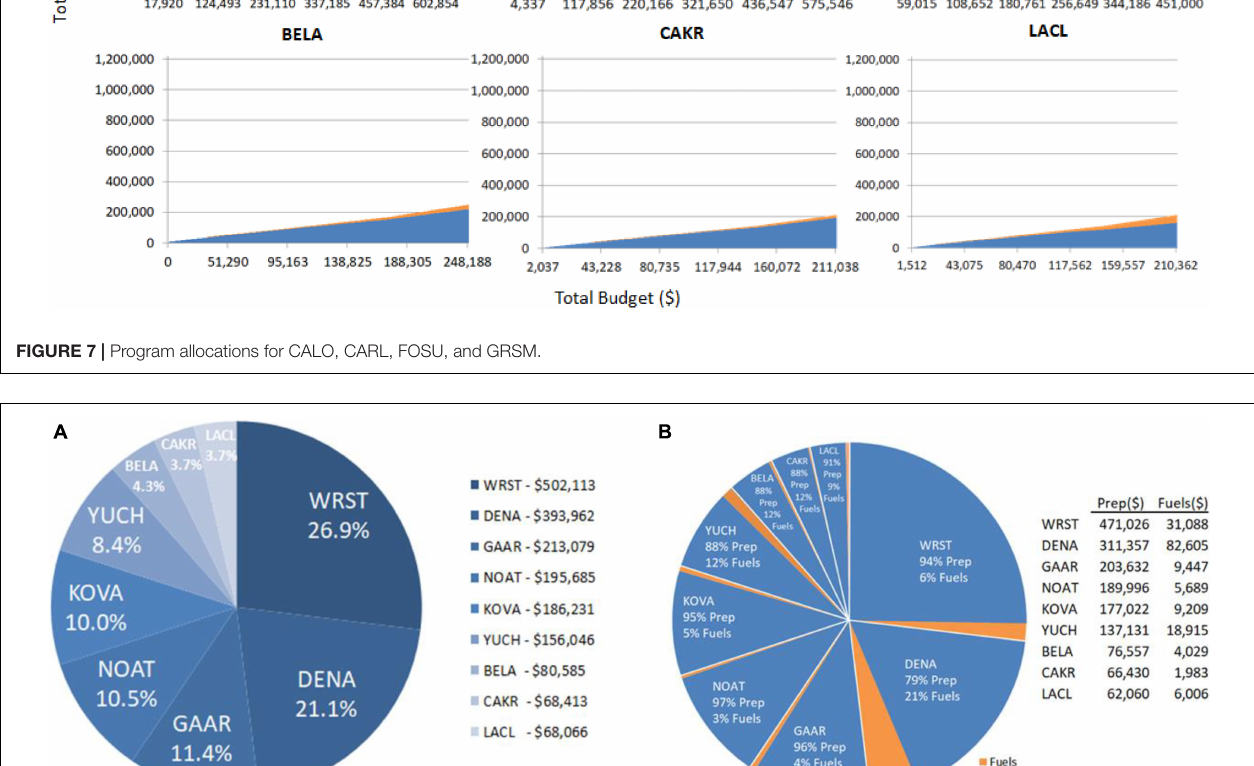
to budgeting decisions. For demonstration, assume that the NPS Alaska Zone has been given a total wildland fire management budget of $1,864,181. The NPS budgeting officer(s) would locate the matching budget amount ( Figure 6 ) from the Zonal Analysis (stage 2). They would then calculate the proportion of funding to